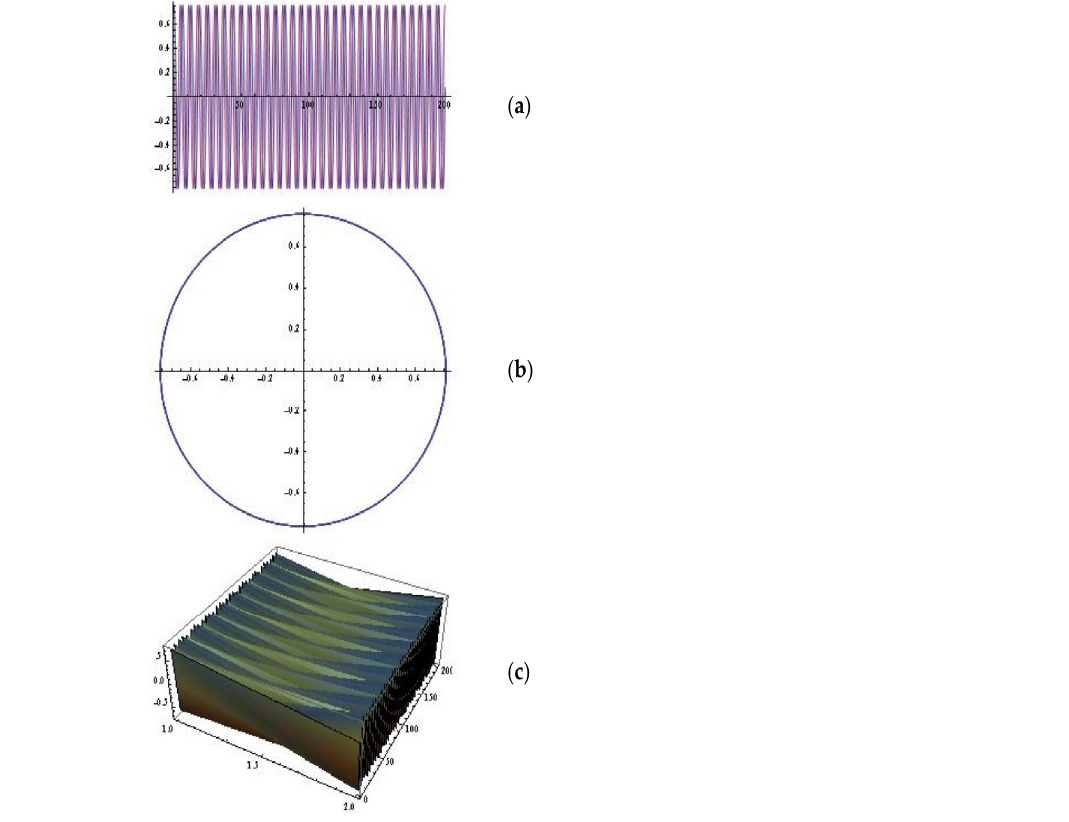
Figure 7. ( a ) The solutions of the system (6) ( (cid:101) = 0.001; n = 5; µ = 7.2); ( b ) the portrait ( x , y ) ; ( c ) 3D plot.